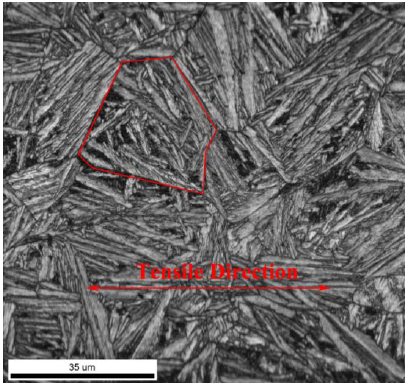
Figure 3. The image quality map of the specimen. Note: the grain encircled by the red polygon is the analyzed region.